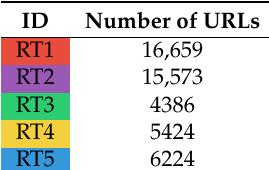
Table A1. Number of URLs per community considered in the entropy calculation after data cleaning.